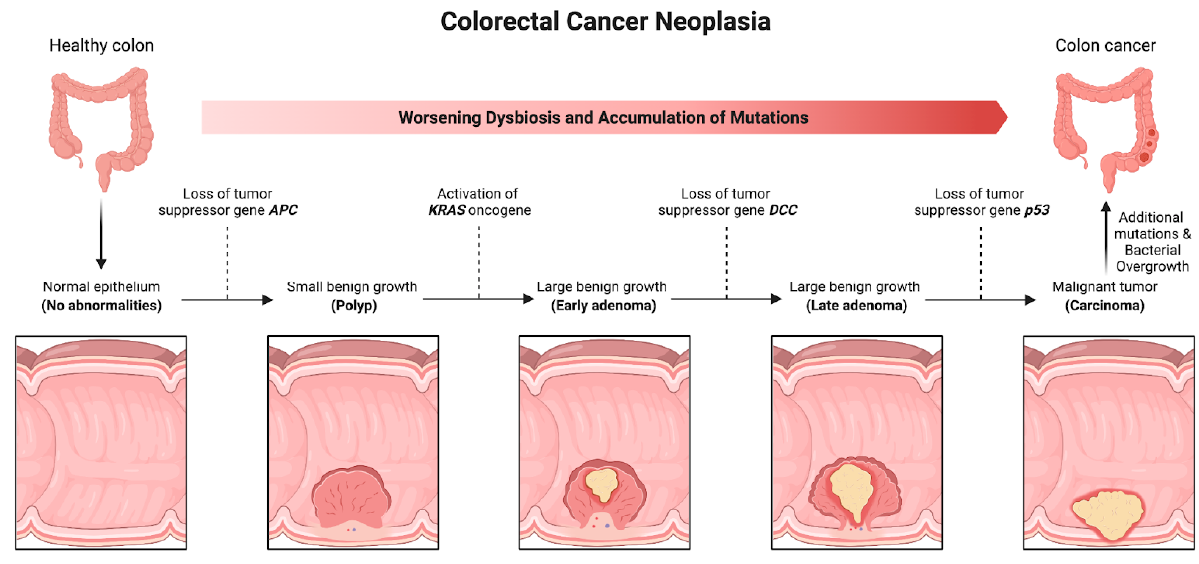
Figure 2. Adenoma–carcinoma sequence. Loss of tumor-suppressor gene, APC, results in hyperpro- liferative epithelium due to loss of cellular adhesion and increased proliferation. Further mutations of KRAS, delete in colorectal cancer (DCC), and p53 accumulate to yield carcinoma. Figure created using biorender.